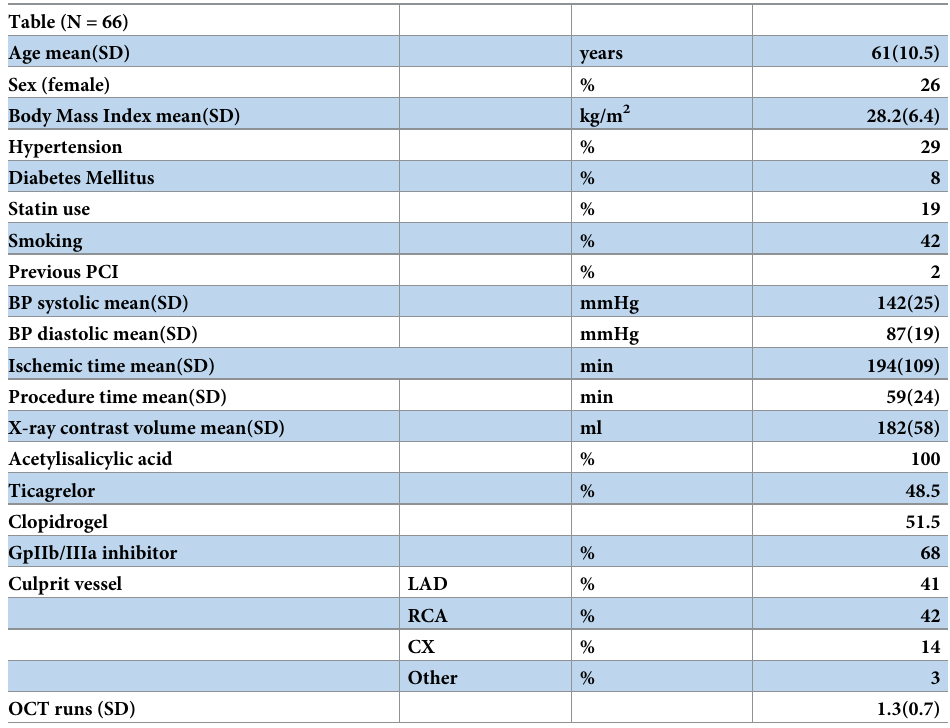
IIIa = Glycoprotein receptor IIb/IIIa, LAD = Left Anterior Descending artery, RCA = Right Coronary Artery,